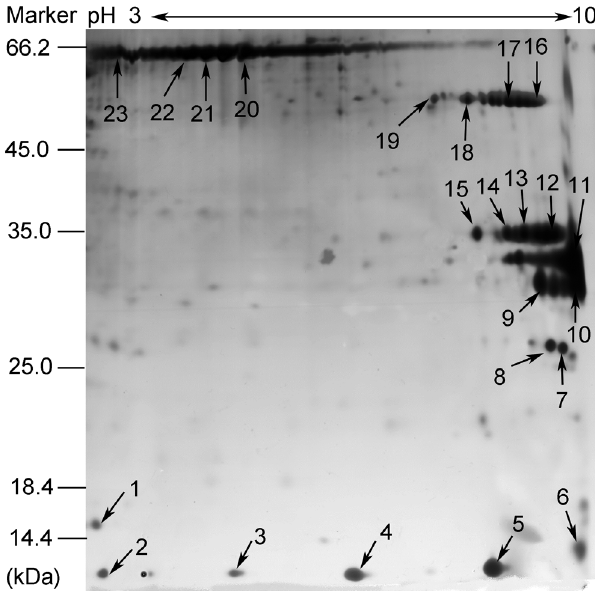
Figure 1. Profile of surface-exposed proteins in R.rickettsii . The isolated biotinylated proteins (300 m g) of R. rickettsii were separated by isoelectric focusing electrophoresis with a pH 3–10 strip followed by 12% SDS-PAGE. The protein spots in the gel were numbered from 1 to 23 and subjected to ESI-MS/MS analysis. The relative molecular masses of the marker proteins are indicated in kDa on the left side of the figure and the proteins identified by ESI-MS/MS are listed in Table 1.